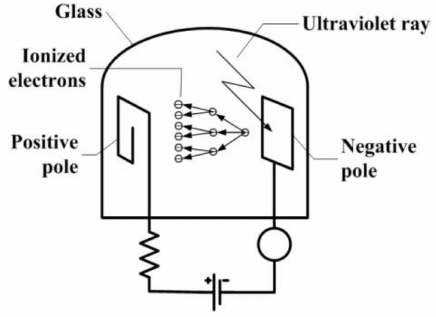
Figure 1. The photosensitive tube schematic